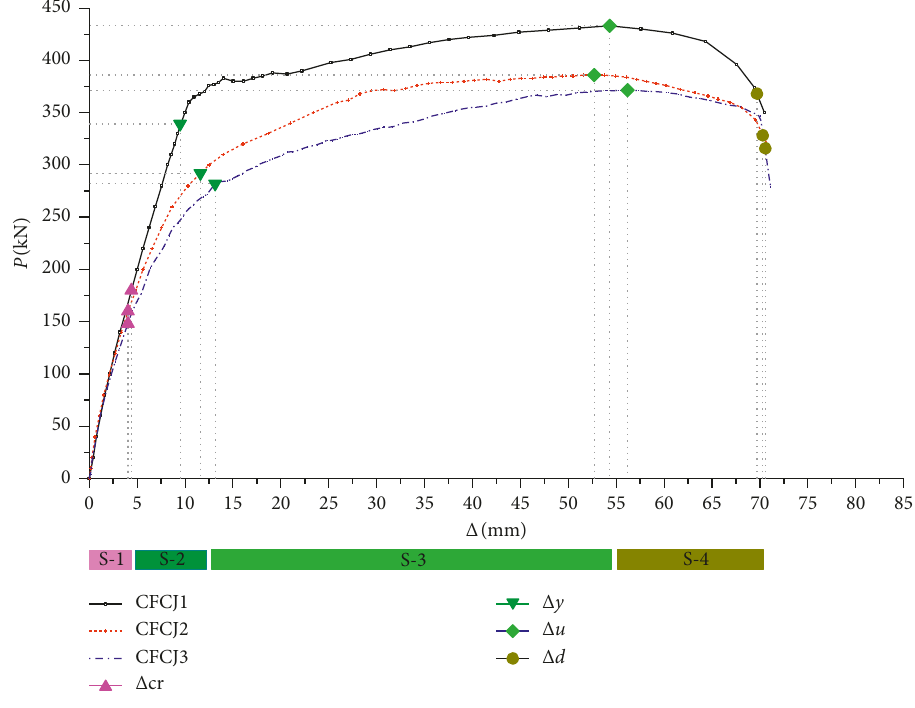
Figure 5: Beam-tip force versus beam-tip displacement